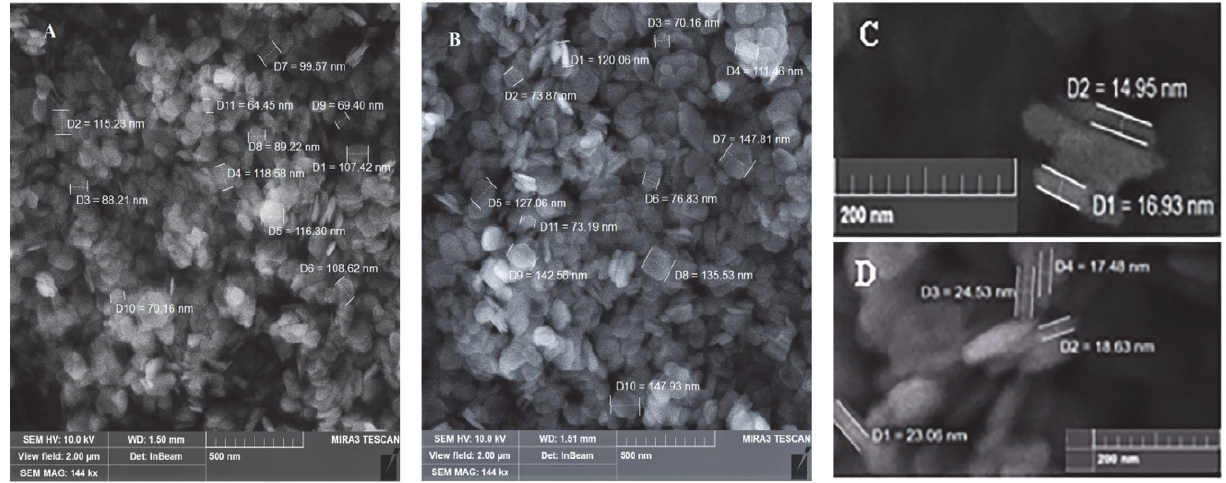
Fig. 4 The SEM images of the I /ZrP: A, C – 1:30, B,D – 1:5